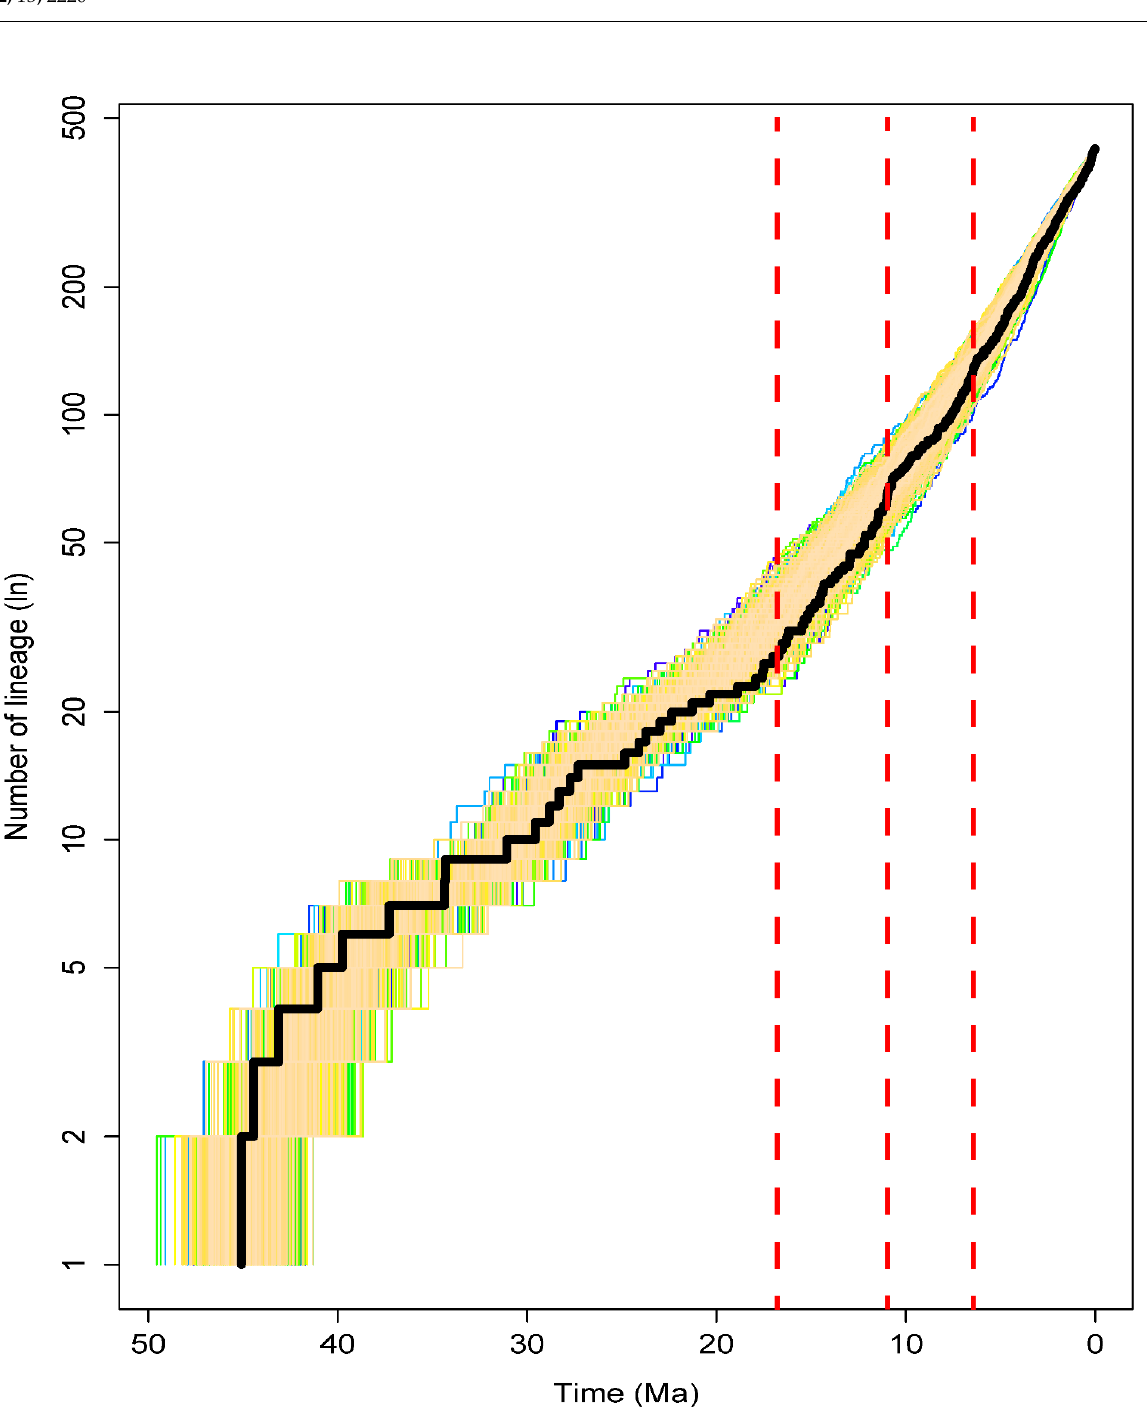
Figure 4. Lineage-through-time (LTT) plots of the Millettiod legumes. Dotted lines in red indicate the rapid increases in diversification rate.